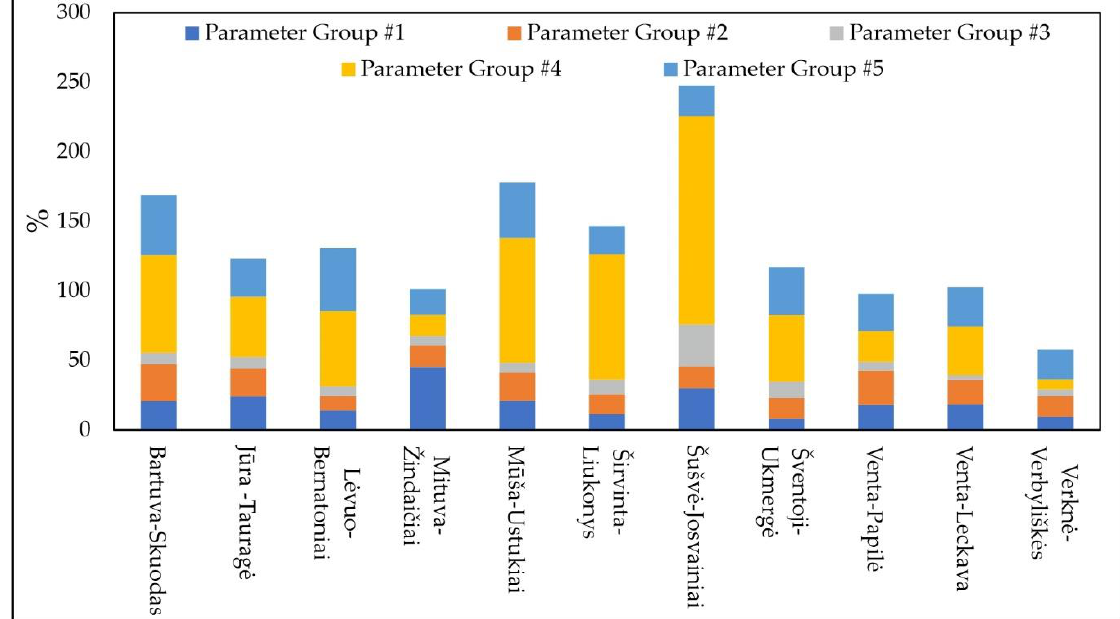
Figure 7. Average changes of the IHA parameters groups at the studied WGSs.